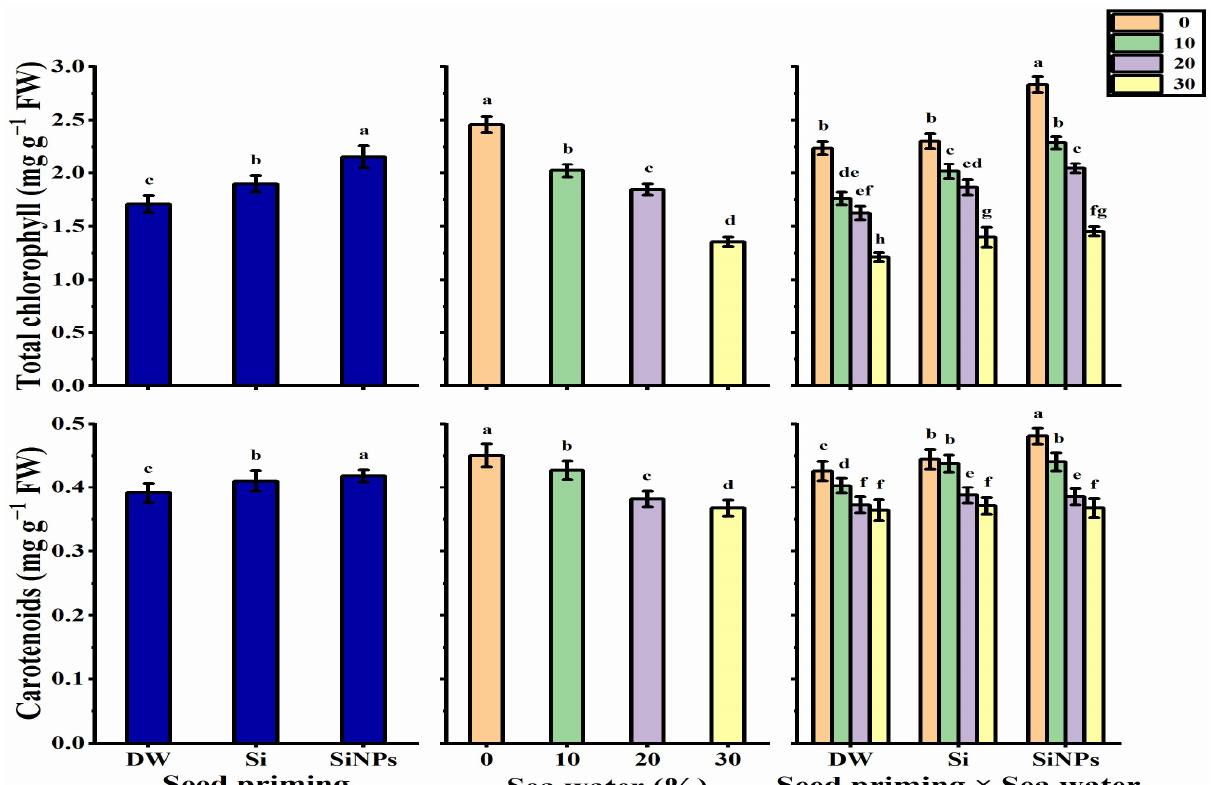
Figure 4. Effect of seed priming on total chlorophyll (mg g − 1 FW) and carotenoids (mg g − 1 FW) contents of Lathyrus odoratus leaves irrigated with seawater levels (0, 10, 20, and 30%). Data are mean value ± SE. Bars with different letters are significantly different at p ≤ 0.05 level.